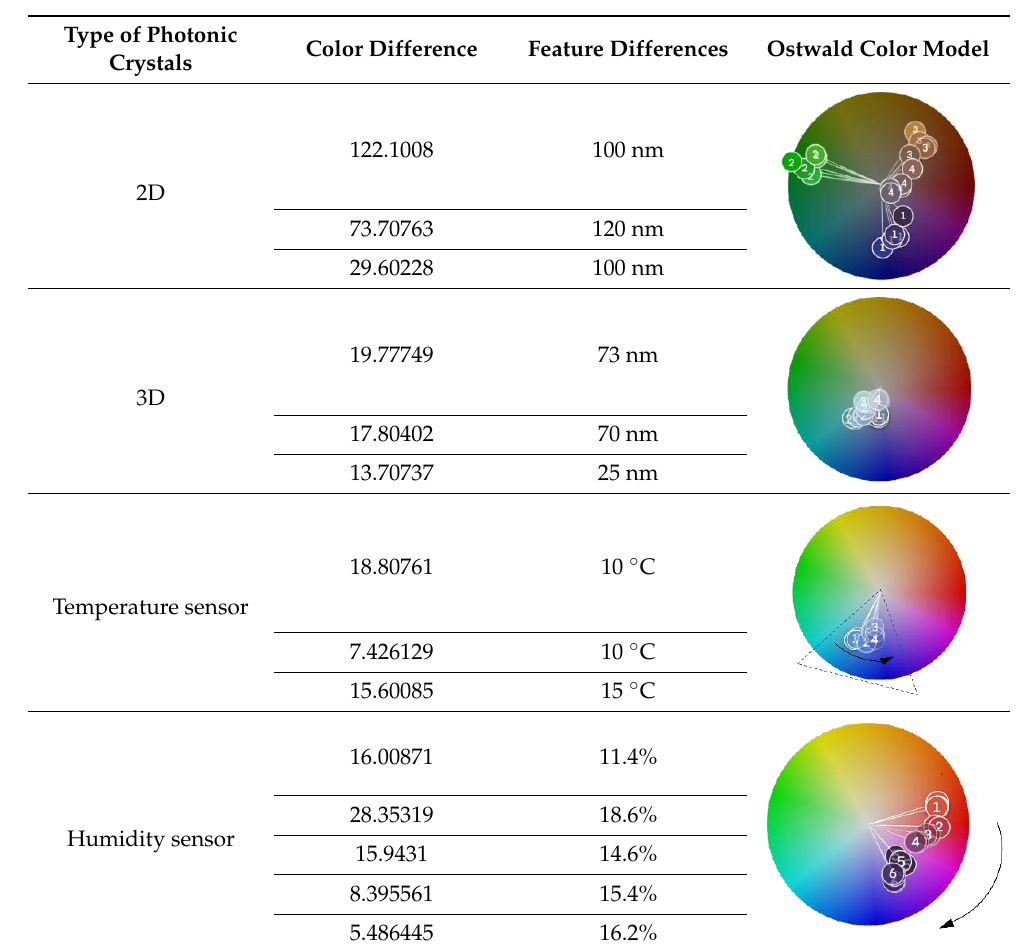
Table 1. Color difference values and Ostwald color model characterization of photonic crystal hydrogel